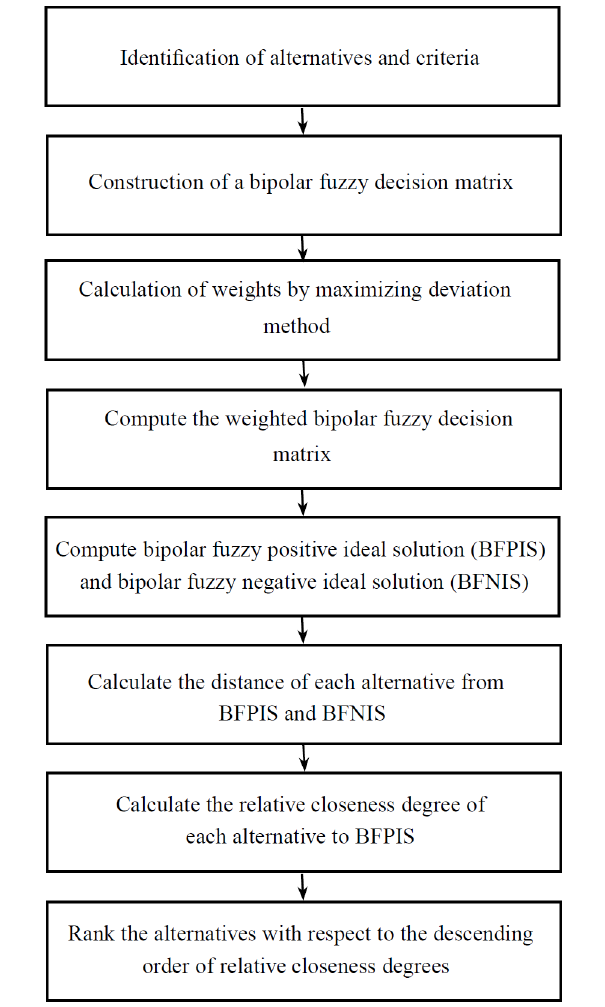
Figure 3. The steps of bipolar fuzzy TOPSIS